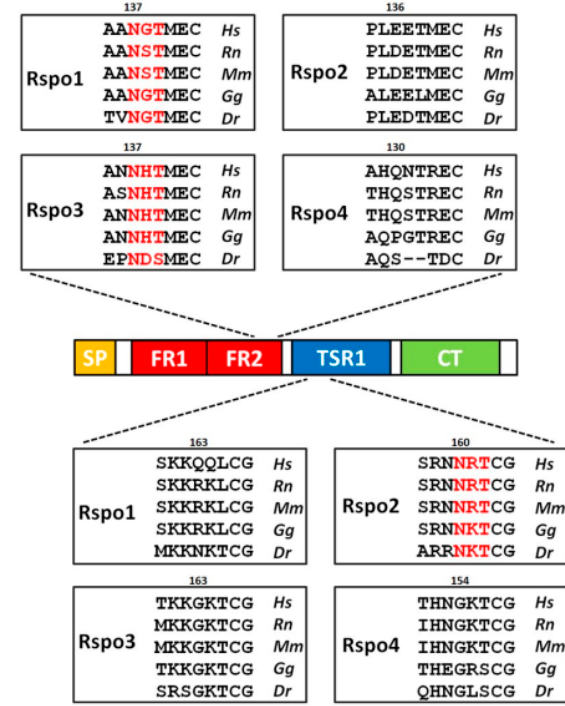
Figure 2. Cont. Figure 2.